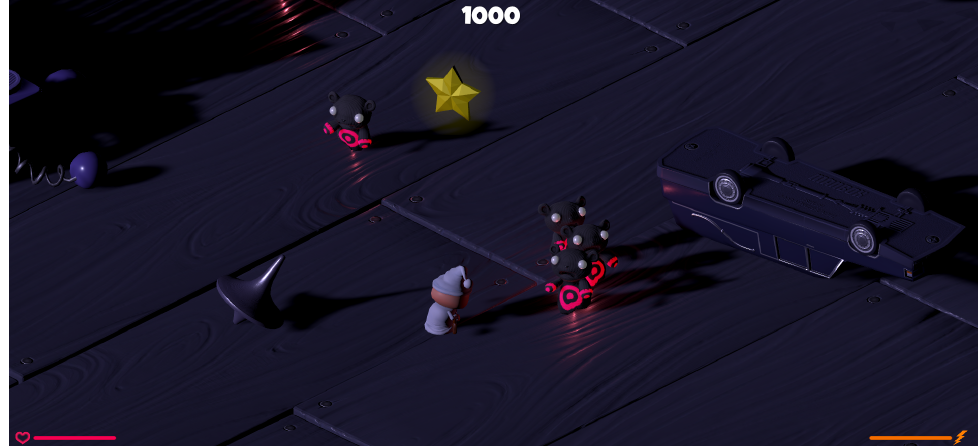
Figure 5. An example of the “Freud me out 2” gameplay